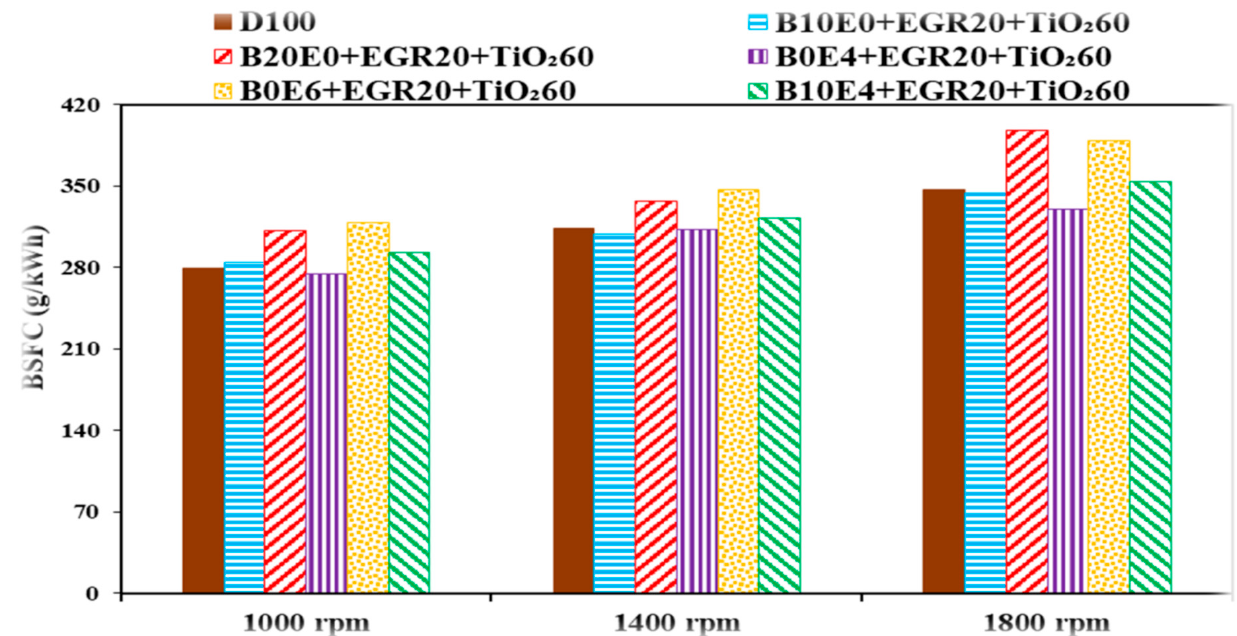
Figure 7. Variation of BSFC for diesel/ethanol/biodiesel blends at EGR = 20%, TiO 2 = 60 ppm, and various engine speeds.